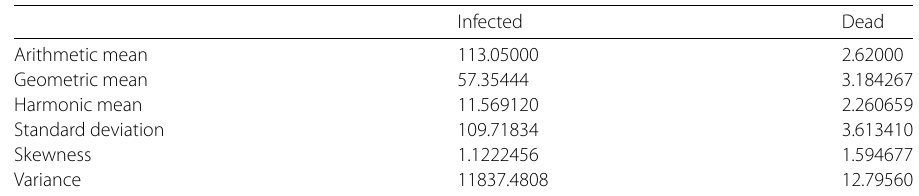
Table 3 Some data about coronavirus cases in South Africa